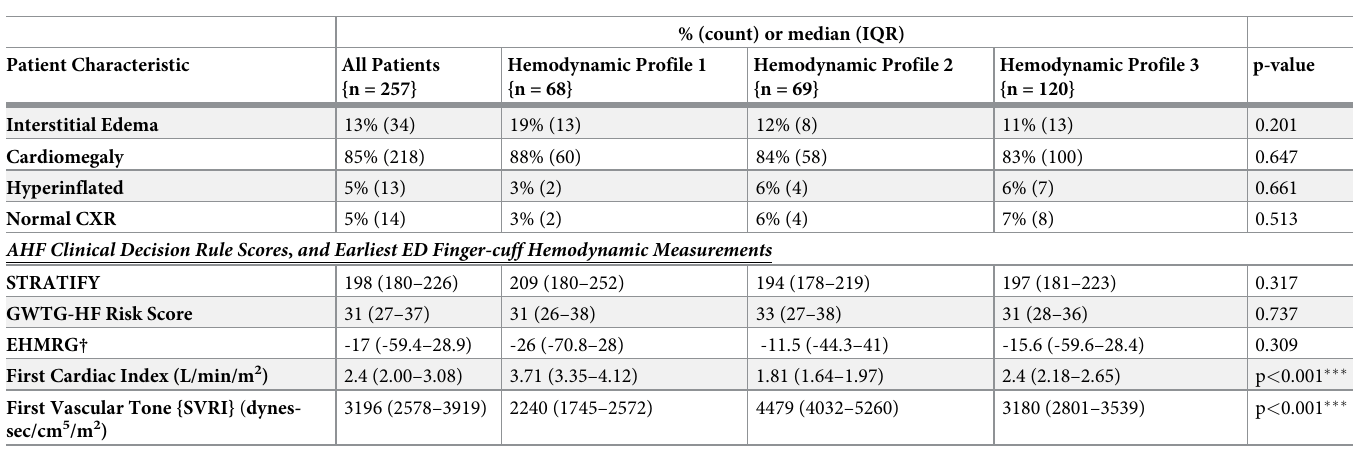
Table 1 Legend— EMS = Emergency medical services; ED = Emergency department; COPD = Chronic obstructive pulmonary disease; HFrEF = Heart failure with reduced ejection fraction; HFpEF = HF with preserved EF; ACEi = Angiotensin converting enzyme inhibitor; ARB = Angiotensin receptor blocker; SpO2 =